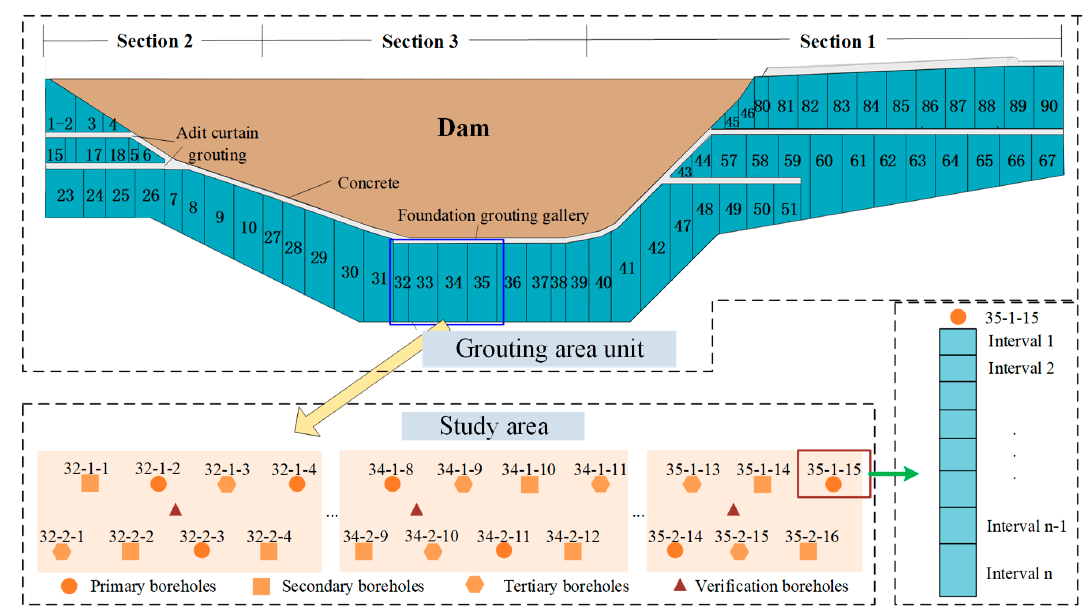
Figure 5. Details of a hydropower station in southwest China.